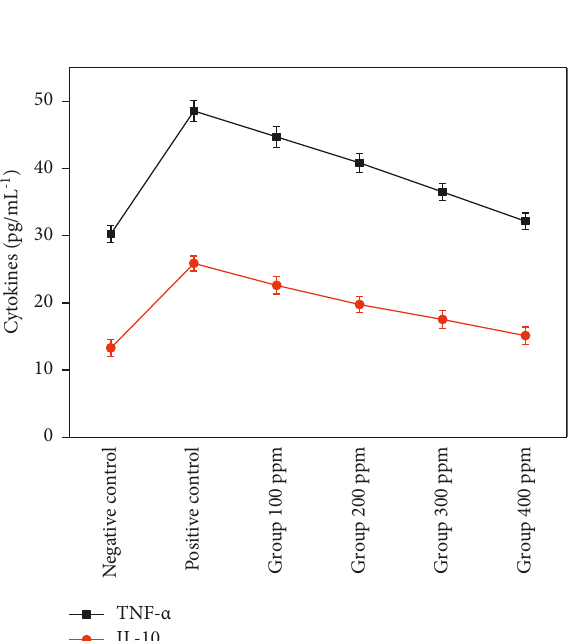
Figure 3: Oxidative stress.